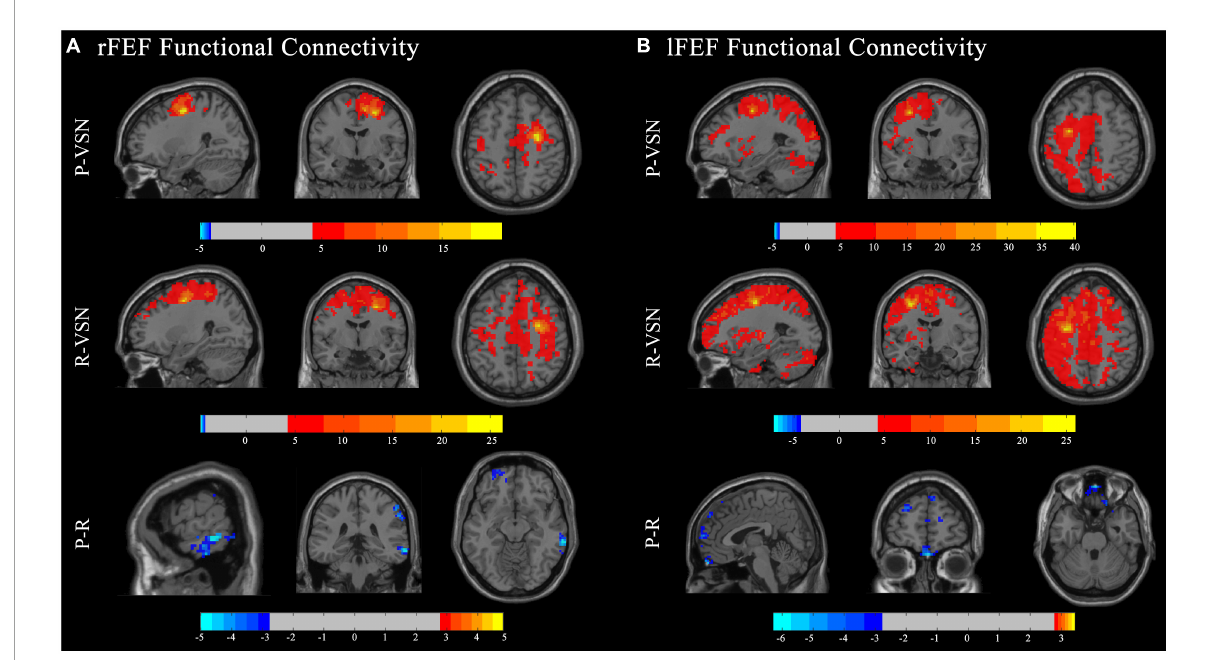
FIGURE3 Functional connectivity (FC) maps. Individual and group comparisons of resting state functional connectivity of seed ROIs rFEF (A) and lFEF (B) . First panel show individual one sample t -test for persistent VSN(P-VSN) ( p < 0.001). Second panel show individual one sample t -test for rapid recovery VSN(R-VSN) ( p < 0.001). Remaining panels show two-sample t-tests comparing persistent VSN with rapid recovery VSN(P-R) ( p < 0.01).